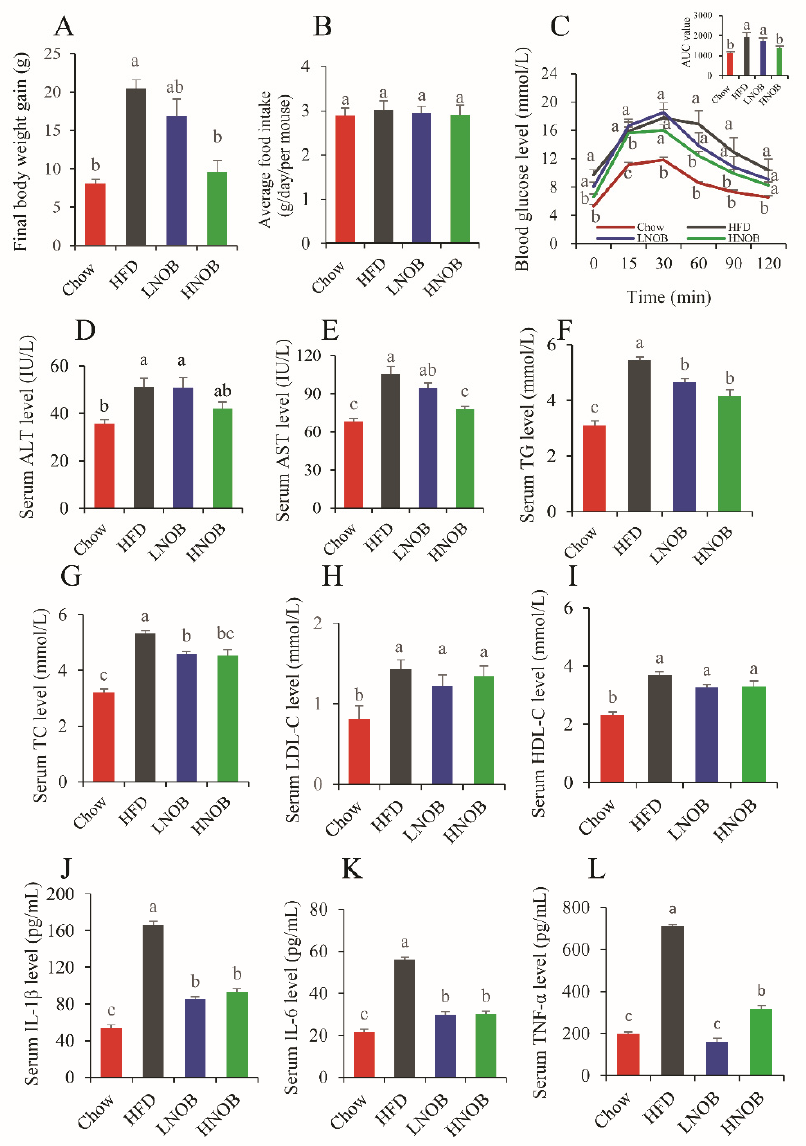
Figure 1. NOB inhibited body weight gain and ameliorated glucose tolerance, serum lipid profiles, as well as inflammatory factors in HFD-induced mice. ( A ) Final body weight gain. ( B ) Food intake. ( C ) GTT and AUC. ( D ) Serum ALT level. ( E ) Serum AST level. ( F ) Serum TG level. ( G ) Serum TC level. ( H ) Serum LDL ‐ C level. ( I ) Serum HDL ‐ C level. ( J ) Serum IL ‐ 1 β level. ( K ) Serum IL ‐ 6 level. ( L ) Serum TNF ‐α . Data are shown as mean ± SD ( n = 8). Data with different letters (a, b, c) represent